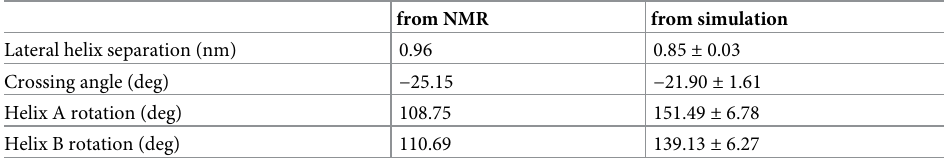
Table 1. Comparison of the NMR and the simulated structures of the inactive TMD form a